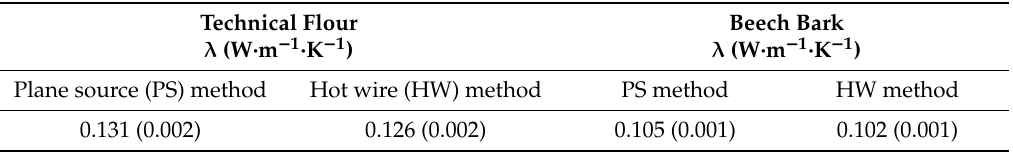
Table 2. Thermal conductivity of technical flour and bark determined using the plane source method (PS) and hot wire (HW) method (values in parenthesis are standard deviations).